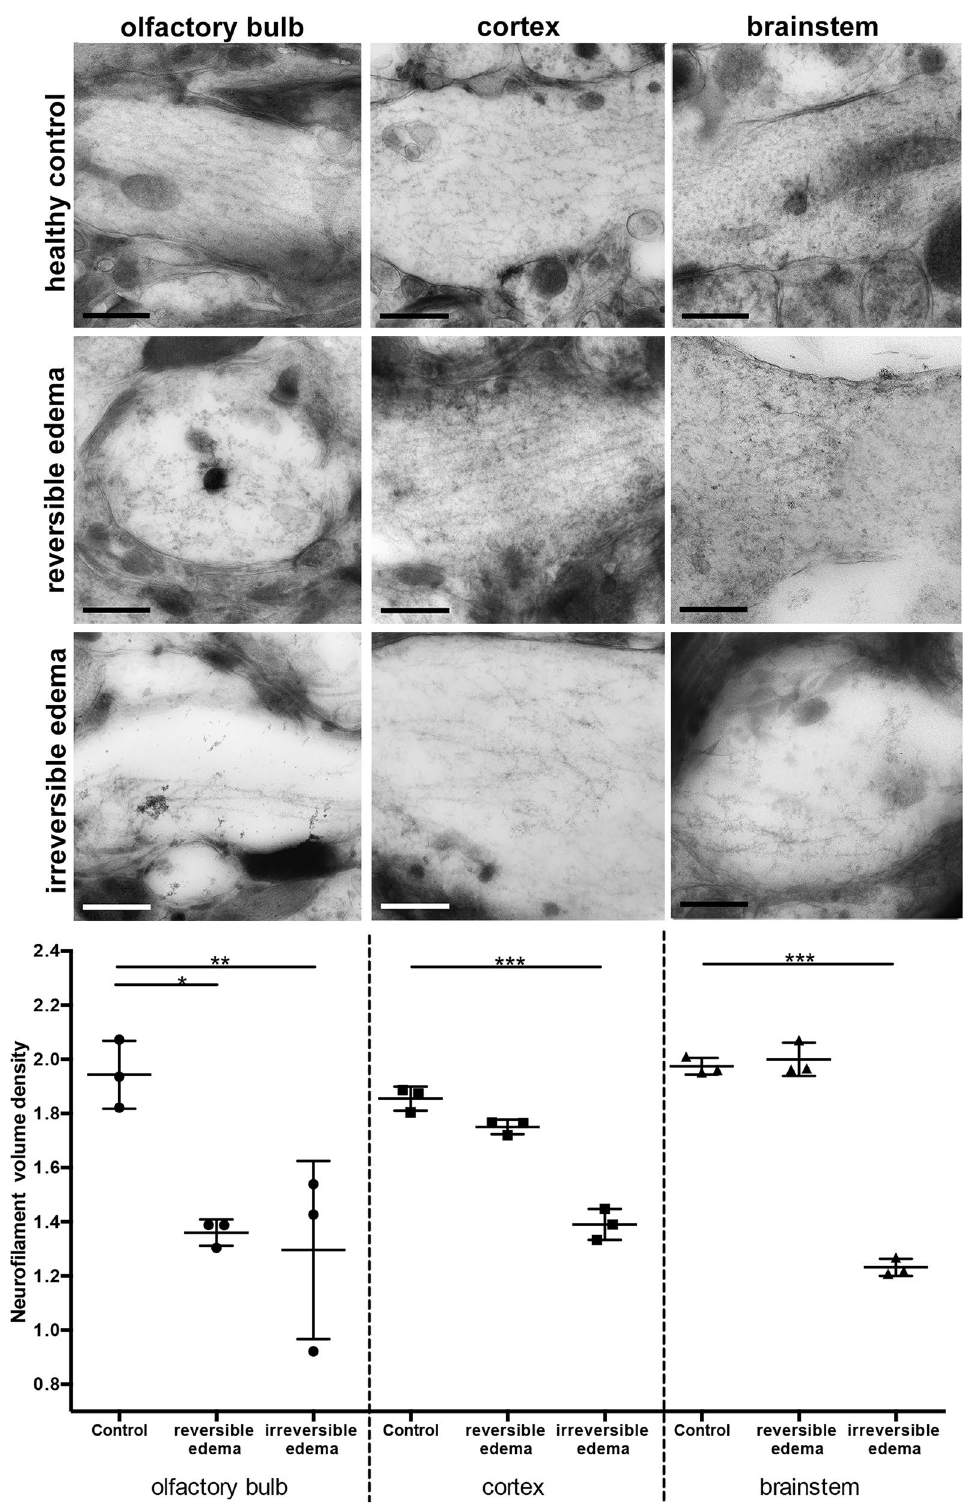
Figure 2. Neurofilaments in different anatomical regions in the acute disease stage. Neurofilament volume density varies depending on disease severity and brain region. EM images show representative neuronal processes for the brain regions olfactory bulb (OB), cortex and brainstem, each in healthy controls, mice with reversible edema and irreversible edema. In control mice neurofilaments run in parallel, while there is a clear loss of neurofilament density and network organization in the OB in mice with reversible and irreversible edema. While no neurofilament alterations are seen in the cortex and brainstem of mice with reversible edema, they are altered in the cortex and brainstem of mice with irreversible edema. The histograms in the last row summarize the measurements of the neurofilaments volume density for each analyzed area of the brain in progressions of disease and in control. Scale bar 200 nm. (n healthy controls = 3 per region, n reversible edema = 3 per region, n irreversible edema = 3 per